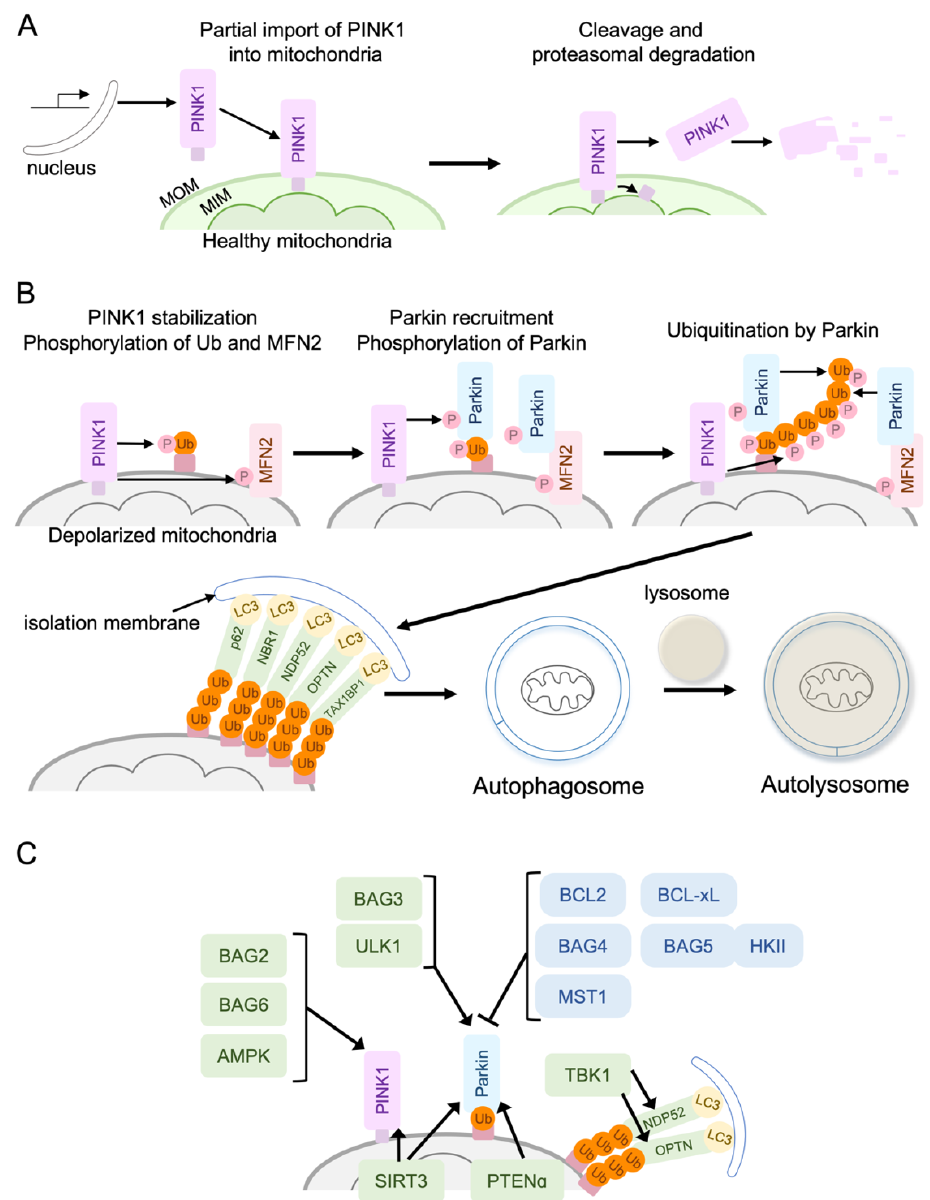
Figure 3. The PINK1/Parkin-mediated mitophagy. ( A ) In healthy cells, PINK1, a mitochondrial serine/threonine kinase, is cleaved by an inner-mitochondrial membrane protease, and the cleaved PINK1 is then retro-translocated to the cytosol where it undergoes proteasomal degradation. ( B ) Under stress conditions, dissipation of mitochondrial membrane potential leads to the inhibition of PINK1 cleavage and supports the accumulation of full-length PINK1 at the MOM. PINK1 phos- phorylates basal MOM ubiquitin which drives Parkin recruitment to the mitochondria and further phosphorylates Parkin to stabilize the binding of Parkin to ubiquitin. In addition, PINK1 phos- phorylates mitofusin-2 (MFN2), a mitochondria fusion protein, which also serves as a receptor for Parkin at MOM. Ubiquitinated mitochondria are recognized by the autophagosome membrane through the autophagy receptor proteins, which interact with LC3 on the autophagosome membrane. ( C ) Signaling molecules regulating the PINK1/Parkin